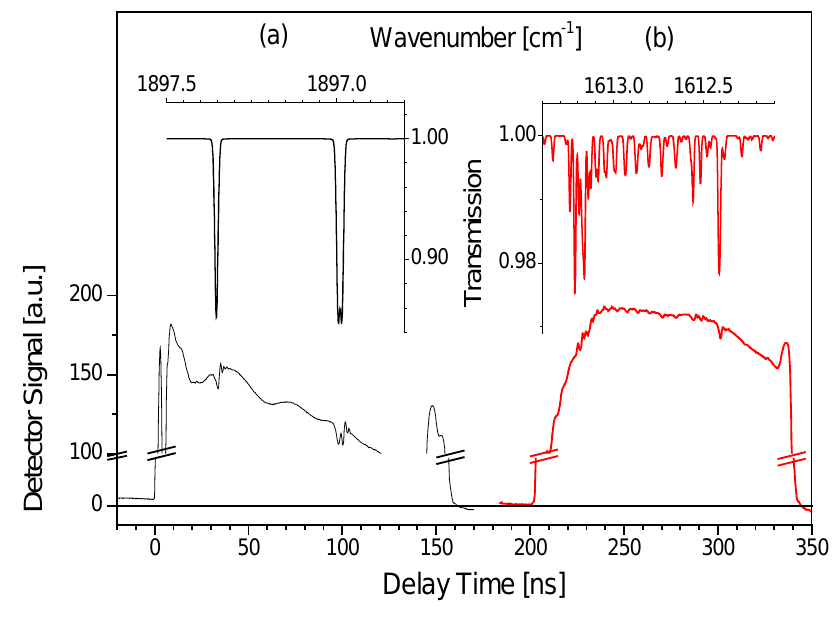
Figure 15. Lower: Experimental spectra of two multiplexed pulsed QCLs synchronized to a trigger event at t = 0. Upper: Calculated spectra for the specific emission ranges of both QCLs. (a) Rapid spectral sweep at ~1,897 cm -1 (5.27 µm) during a 150 ns QCL pulse showing absorption features of NO (50 cm absorption length, 2.66 mbar). (b) Spectral sweep of a pulsed QCL (150 ns pulse length) emitting around 1,613 cm -1 (6.20 µm) to observe NO absorption lines using the same conditions as in (a) 2